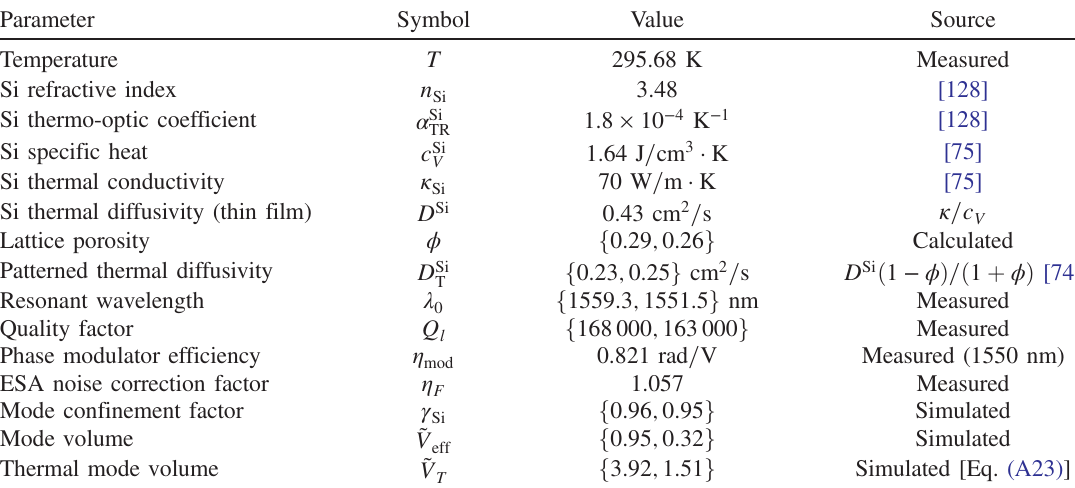
TABLE I. Parameters used for calibrating the noise spectrum and computing or fitting Γ n for L 3 and L 4 = 3 microcavities are listed as f n ∼ 1 confirms the validity of Eq. (B15), which assumes complete confinement of the mode in factor γ Si